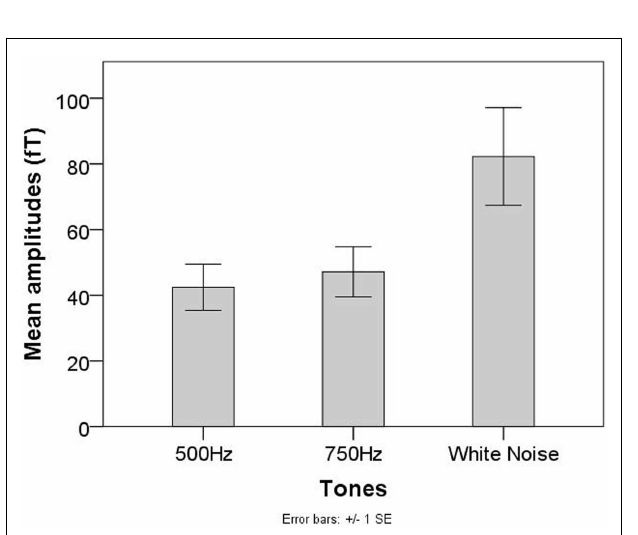
FIGURE 4 | MeanAER amplitudes for the 500Hz, 750Hz, andWN stimuli in the group of fetuses of theTuebingen study .